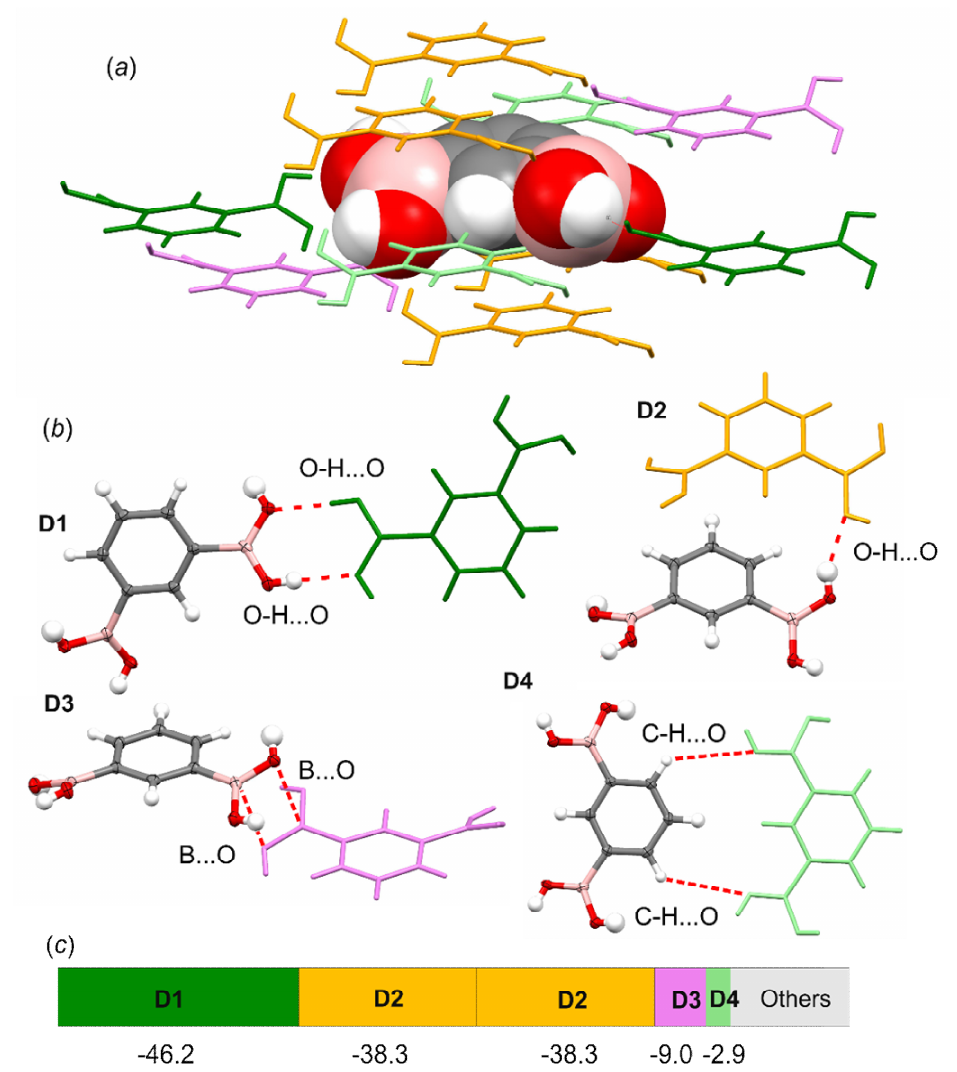
Figure 8. ( a ) Closest molecular environment ( b ) with the dispositions of dimeric motifs and ( c )